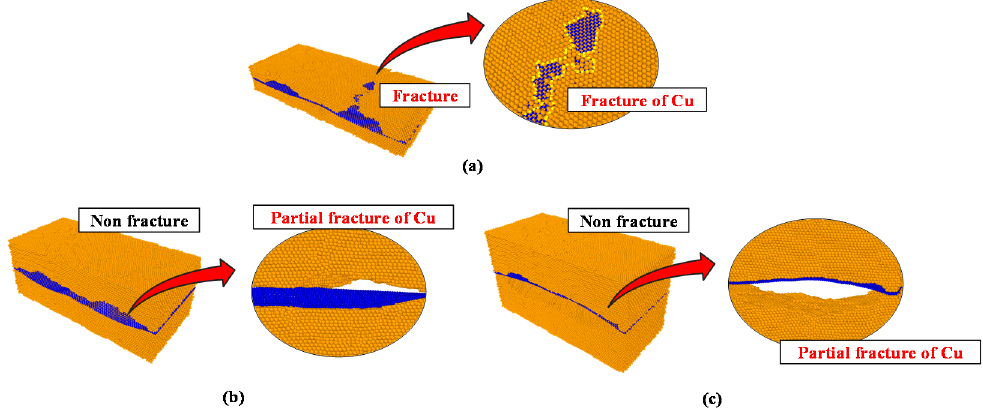
Figure 5. Fracture phenomenon with respect to the zigzag direction. ( a ) Model A; ( b ) model B; ( c ) model C.